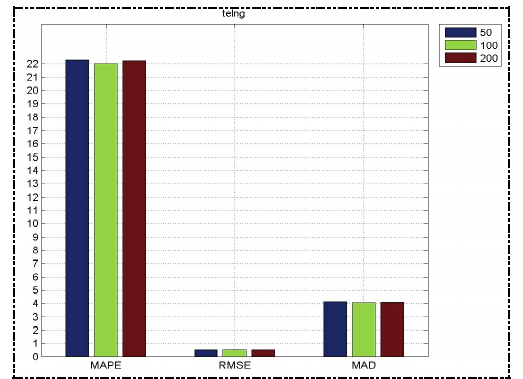
Fig.8. Performance evaluation graph of MAPE, RMSE and MAD values of various hidden layers in proposed technique for dataset 3